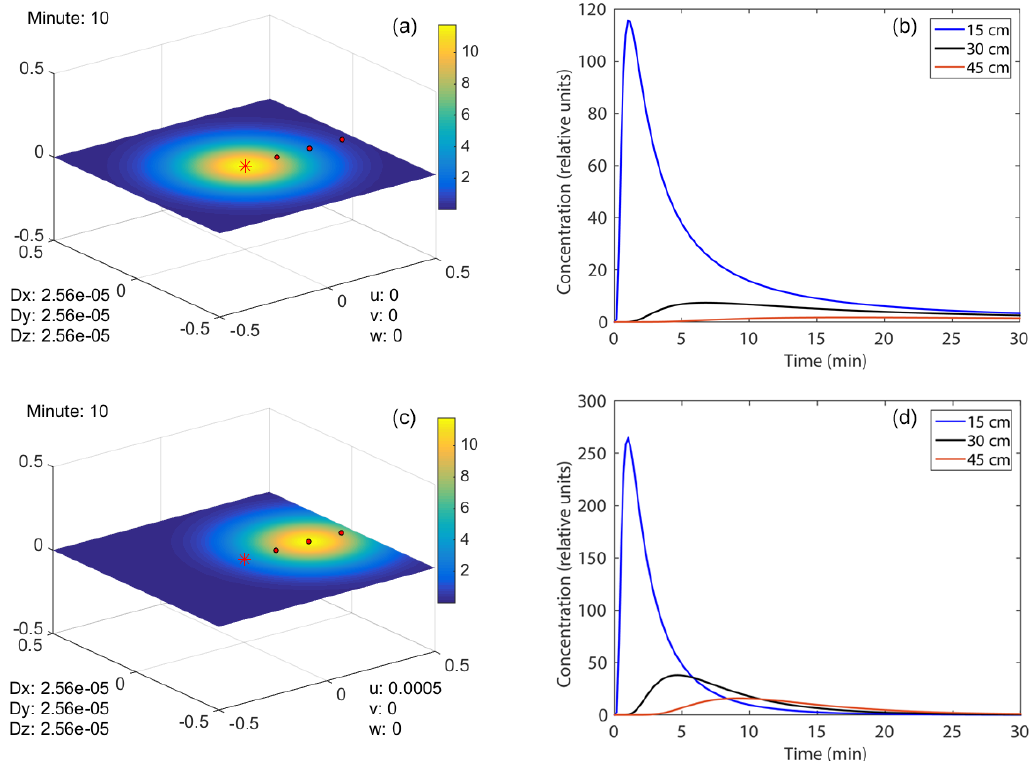
Figure 4. Horizontal cross section of simulated plume dispersion in a purely diffusive case over a 1m 3 volume (a) and the associated breakthrough curve (b) and for a diffusive–advective case (c) with the associated breakthrough curve (d) . The red asterisks in panels (a) and (c) mark the plume release point. For the advective–diffusive scenario, plume concentration is greater at the 30cm position than the 15cm position after